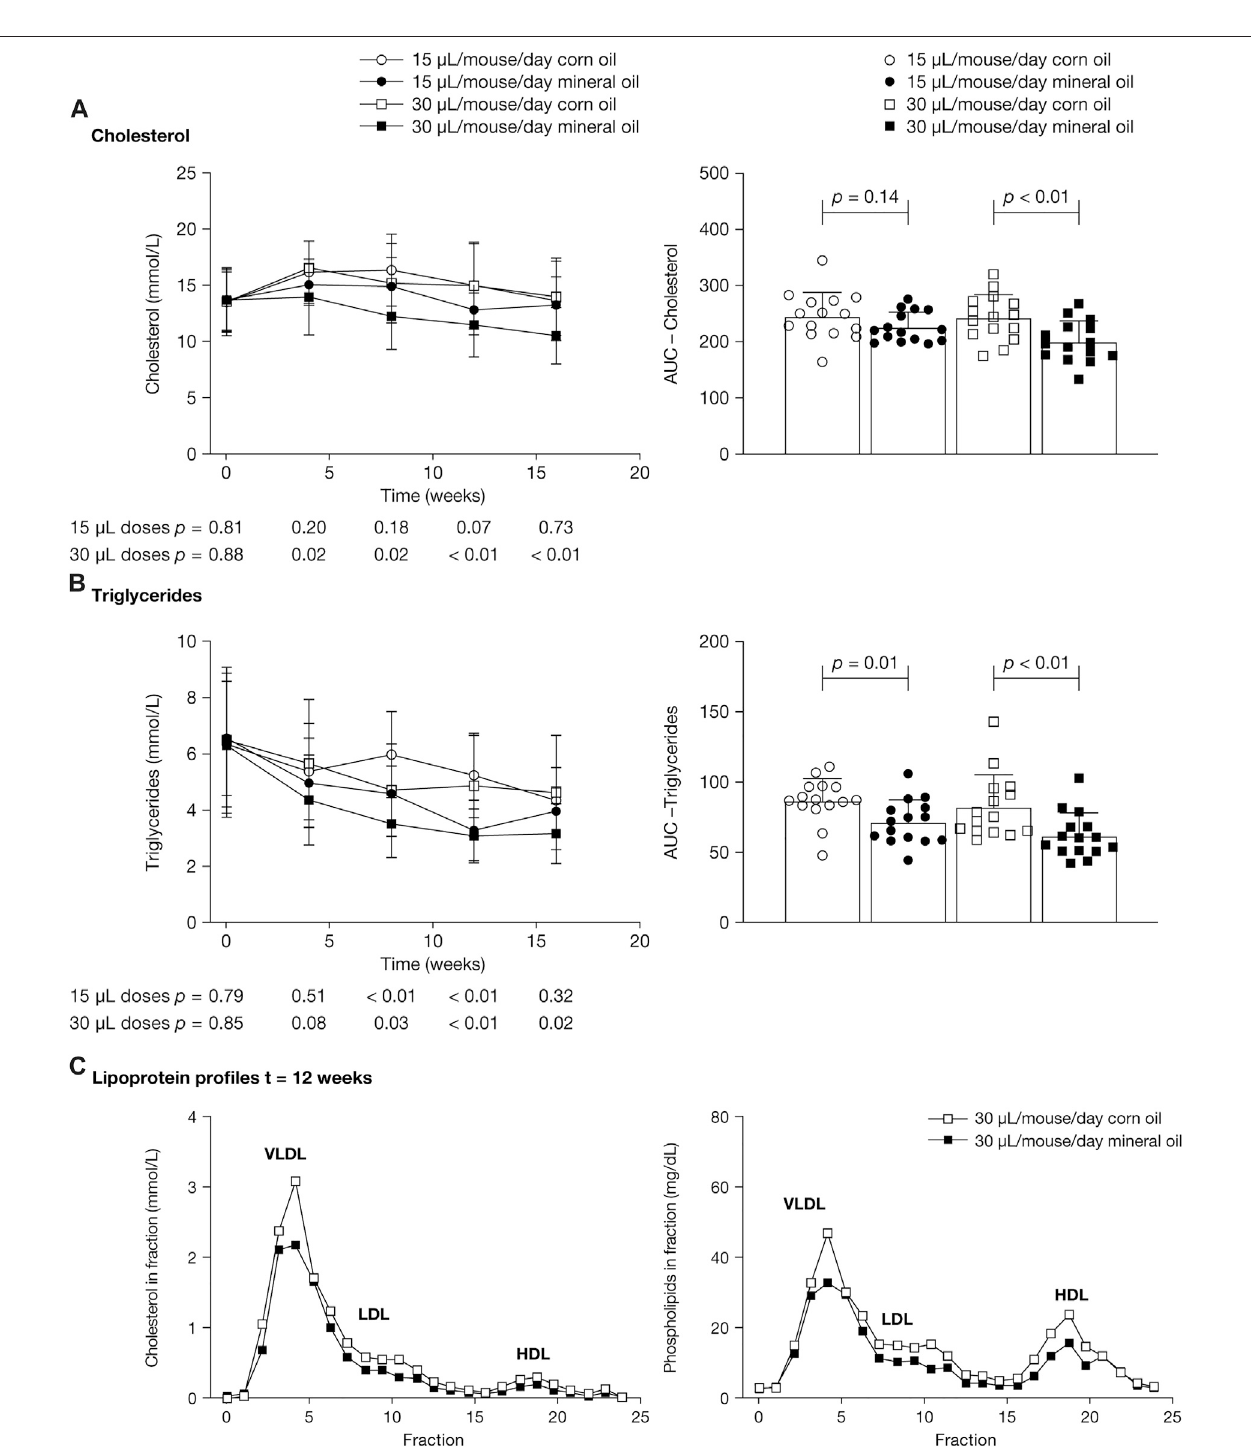
FIGURE 3 | Mean (SD) plasma concentrations at 0, 4, 8, 12, and 16 weeks (left panels) and area under the concentration – time curve (right panels) for (A) cholesterol and (B) triglycerides. p -values were calculated using independent samples t -test. (C) Lipoproteins from pooled plasma samples were size-fractionated and analyzed by fast protein liquid chromatography. Pro fi les across the fractions from samples at 12 weeks are shown for cholesterol (left panel) and phospholipids (right panel).AUC,areaunder theconcentration – time curve;HDL,high-densitylipoprotein; LDL, low-densitylipoprotein;SD,standarddeviation; VLDL,verylow-density